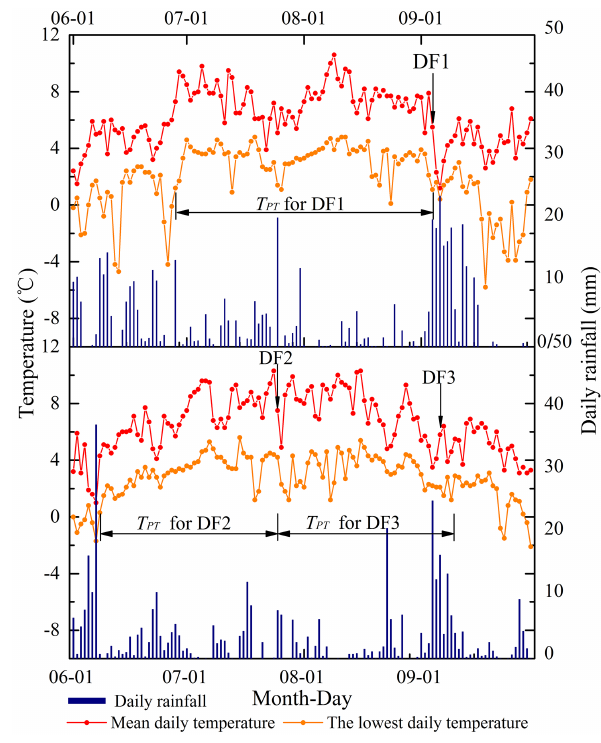
Figure 6. Distribution and changes in glacier, snow, bare land, gully deposition and vegetation in Tianmo Valley.